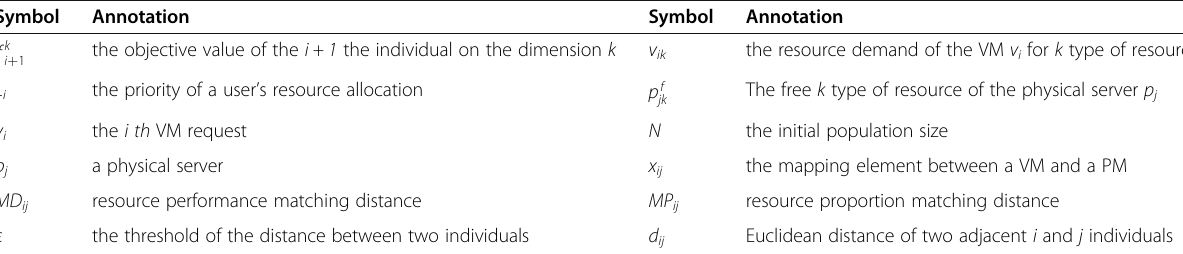
Table 1 List of mathematical notations Symbol Annotation